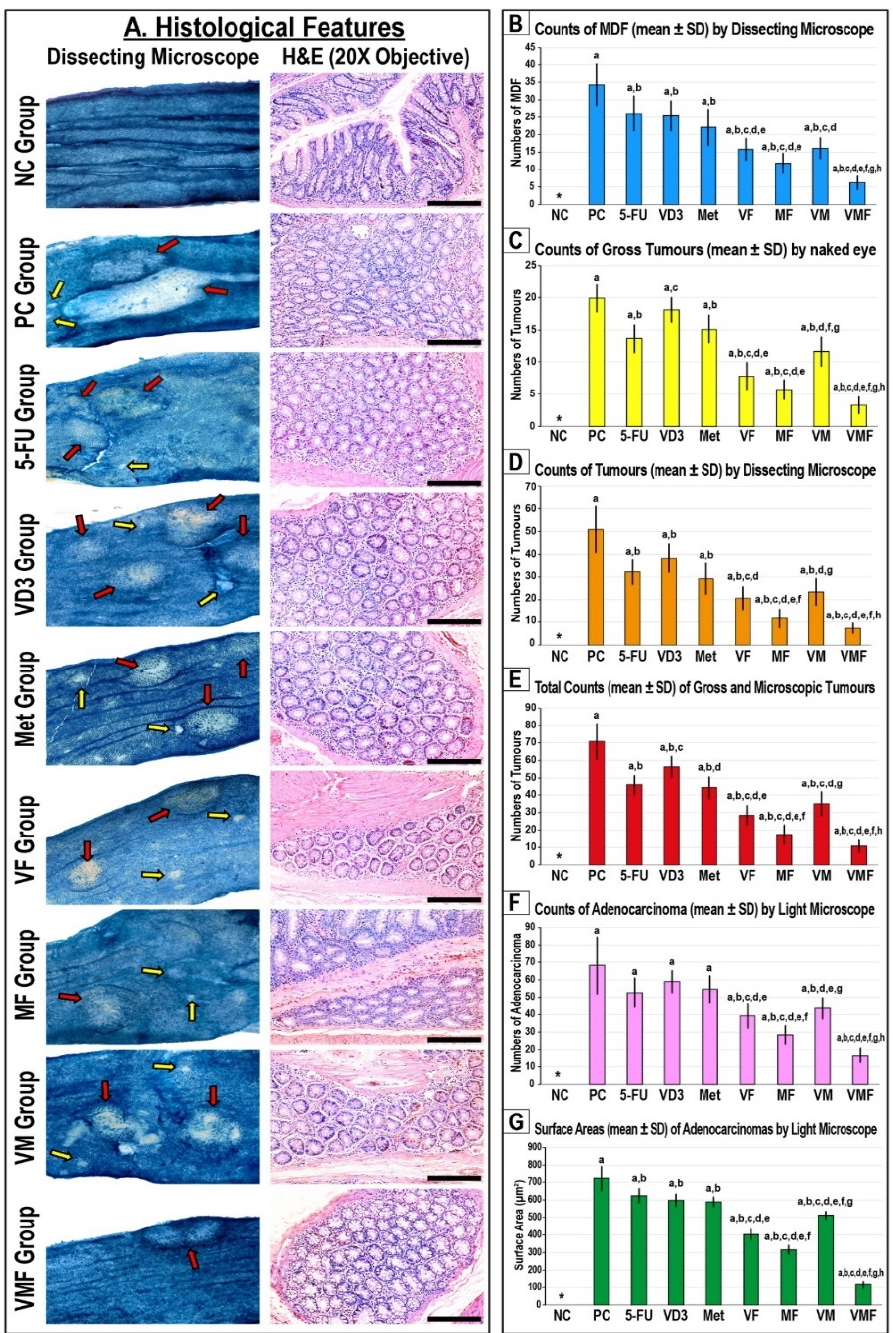
Figure 1. ( A ) Mouse colon mucosa from all the study groups under a dissecting microscope (n = 10 mice/group; ×20 magnification; red arrow = tumours; yellow arrow = mucin-depleted foci (MDF)) alongside colonic tissue sections from all groups by H&E stain (n = 10 mice/group; ×200 magnification; scale bar = 15 µm). Furthermore, the numbers of ( B ) MDF, ( C ) gross tumours, ( D ) microscopic tumours, ( E ) total tumours, and ( F ) adenocarcinomas alongside ( G ) the adenocarci- nomas’ surface areas are shown as bar graphs (n = 10 mice/group; data were analysed by ANOVA followed by Games–Howell post hoc tests and are shown as the mean ± SD; * = not detected; a = p < 0.05 compared with the NC group; b = p < 0.05 compared with the PC group; c = p < 0.05 compared with 5-FU monotherapy; d = p < 0.05 compared VD 3 monotherapy; e = p < 0.05 compared with Met monotherapy; f = p < 0.05 compared with VF dual therapy; g = p < 0.05 compared with MF dual therapy; and h = p < 0.05 compared with VM dual therapy). * = Not